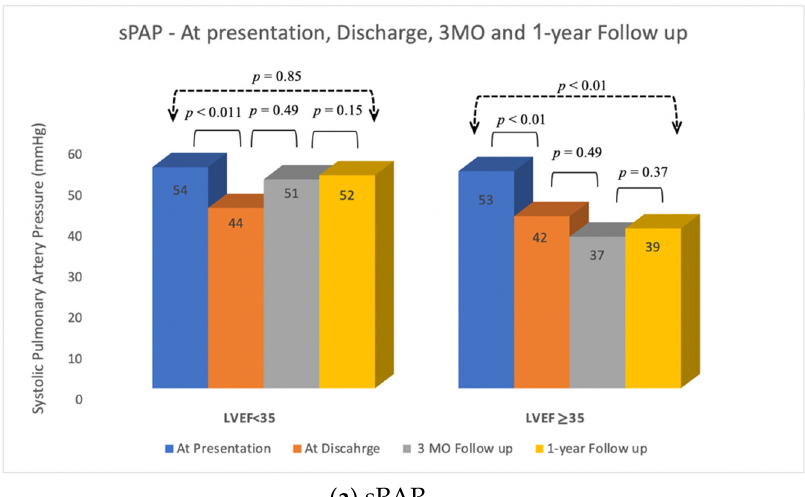
Figure 2. Left Ventricle Ejection Fraction (LVEF) and Left Atrial Pressure (LAP) before and after the procedure. ( a ) There was no significant change in Left ventricle ejection fraction (LVEF) before and after MitraClip procedure in both LVEF < 35% and LVEF ≥ 35% groups; ( b ) There was a significant reduction in LAP before and after MitraClip procedure in both LVEF < 35% and LVEF ≥ 35% groups.